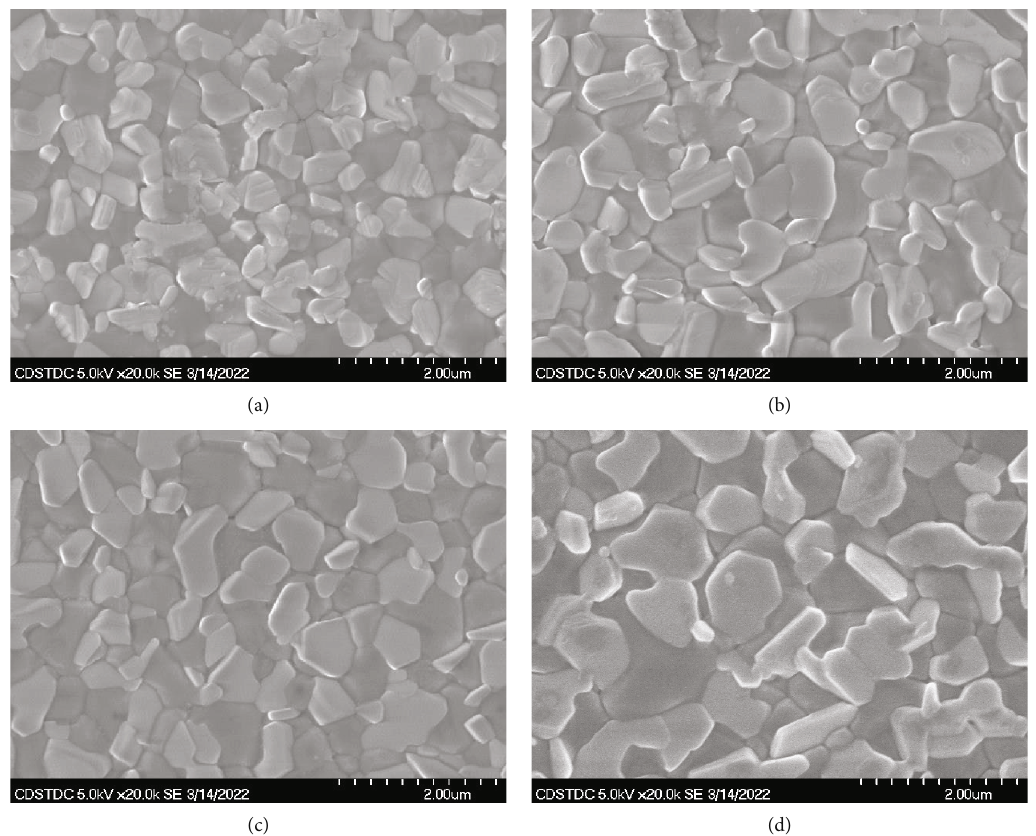
Figure 2: The surface SEM images of perovskite fi lms added di ff erent concentrations of MACl: (a) without MACl; (b) with 2g/L MACl; (c) with 5 g/L MACl; (d) with 10g/L MACl (scale: 2 μ